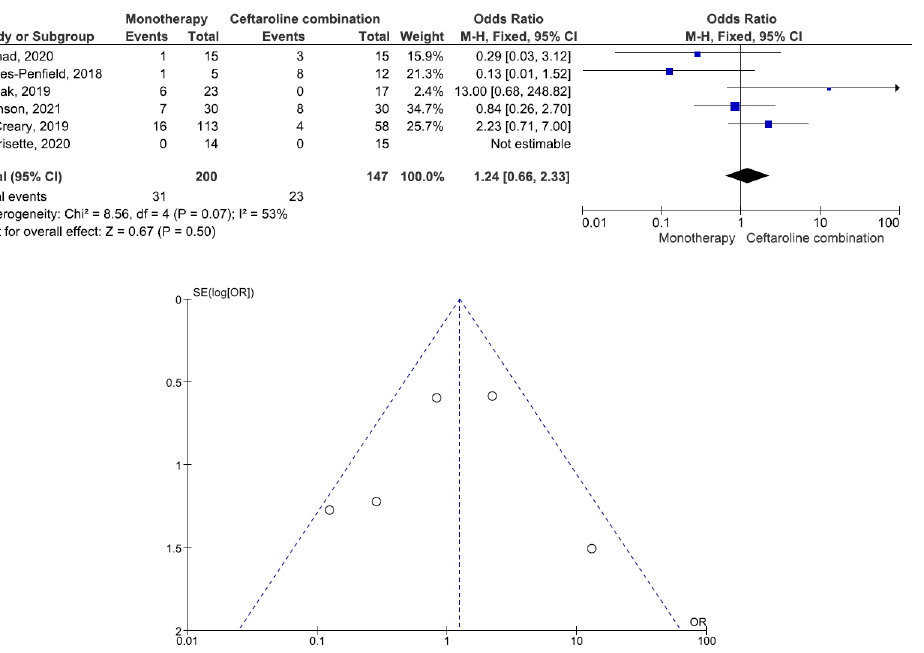
Figure 3. Forest plots and funnel plots for in-hospital mortality between monotherapy and combination therapy in the treatment of methicillin-resistant Staphylococcus aureus bacteremia.